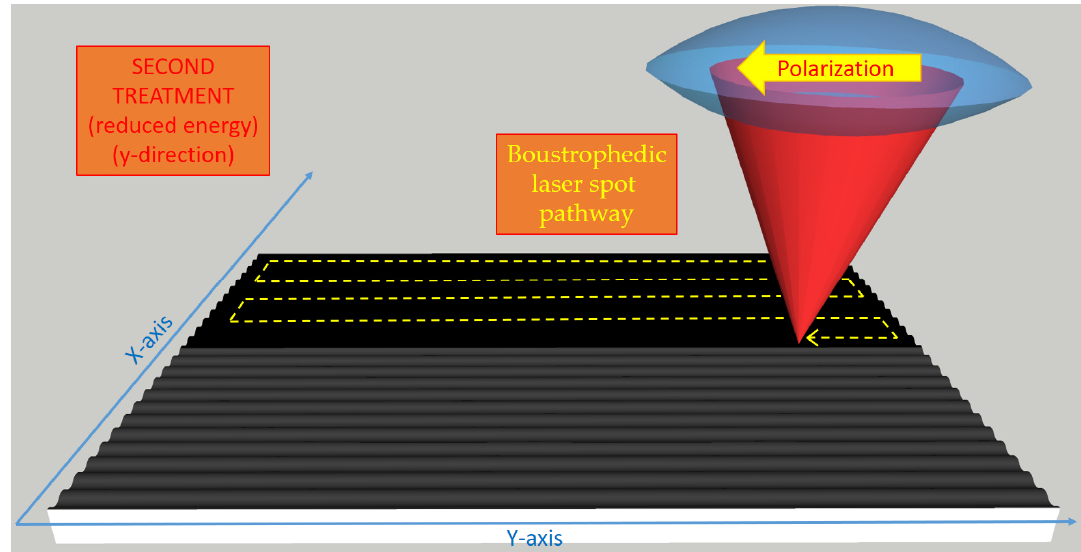
Figure 1. A 3D-view of the two separate boustrophedic fs-laser treatments of the diamond surface. The LIPSS nano-waves’ direction is orthogonal to the light polarization and their thickness is about half a micron. In the lower figure, the larger optical absorbance of the diamond surface after the second treatment is evidenced due to the increased defects’ densities [22].